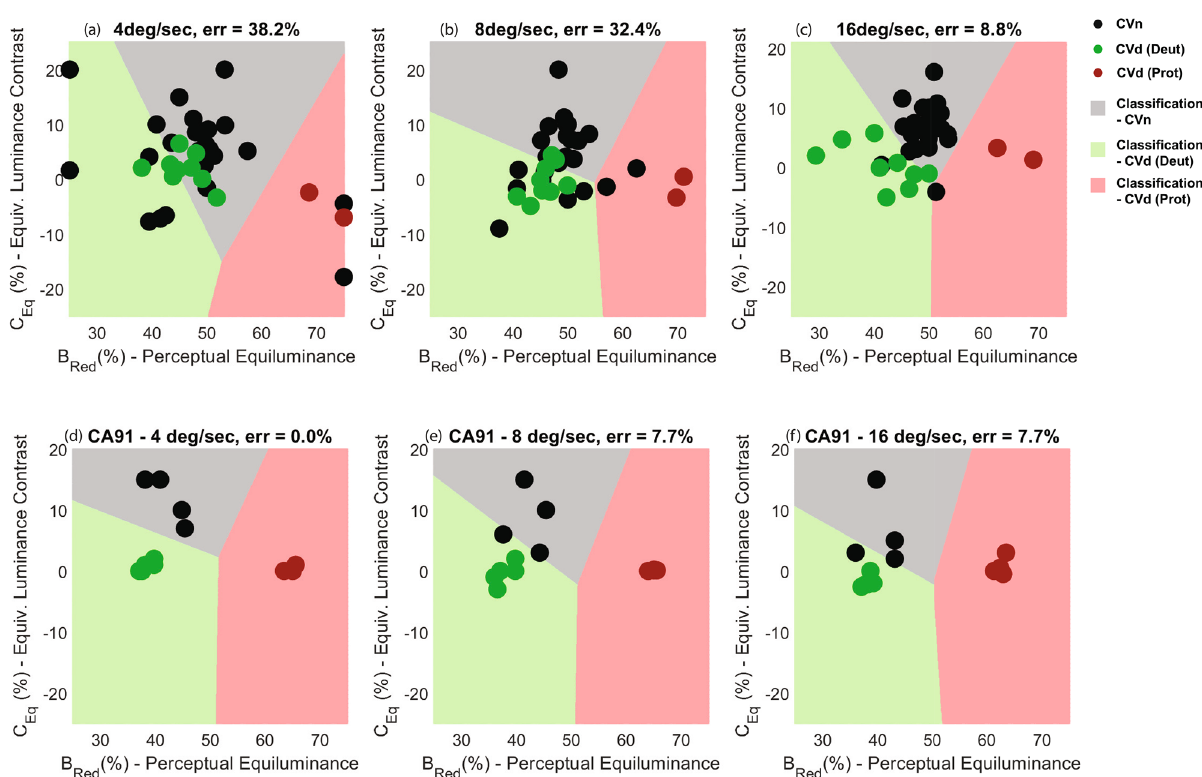
Figure 7. Equibrightness plot against equivalent luminance contrast for ( a – c ) our 30 participants and ( d – f ) Cavanagh and Anstis’ participants, run in the three speed conditions. Boundaries of the coloured regions were derived using a K-means algorithm that sought to best separate the three groups. Error rates indicate the percentage of mis-classified participants.